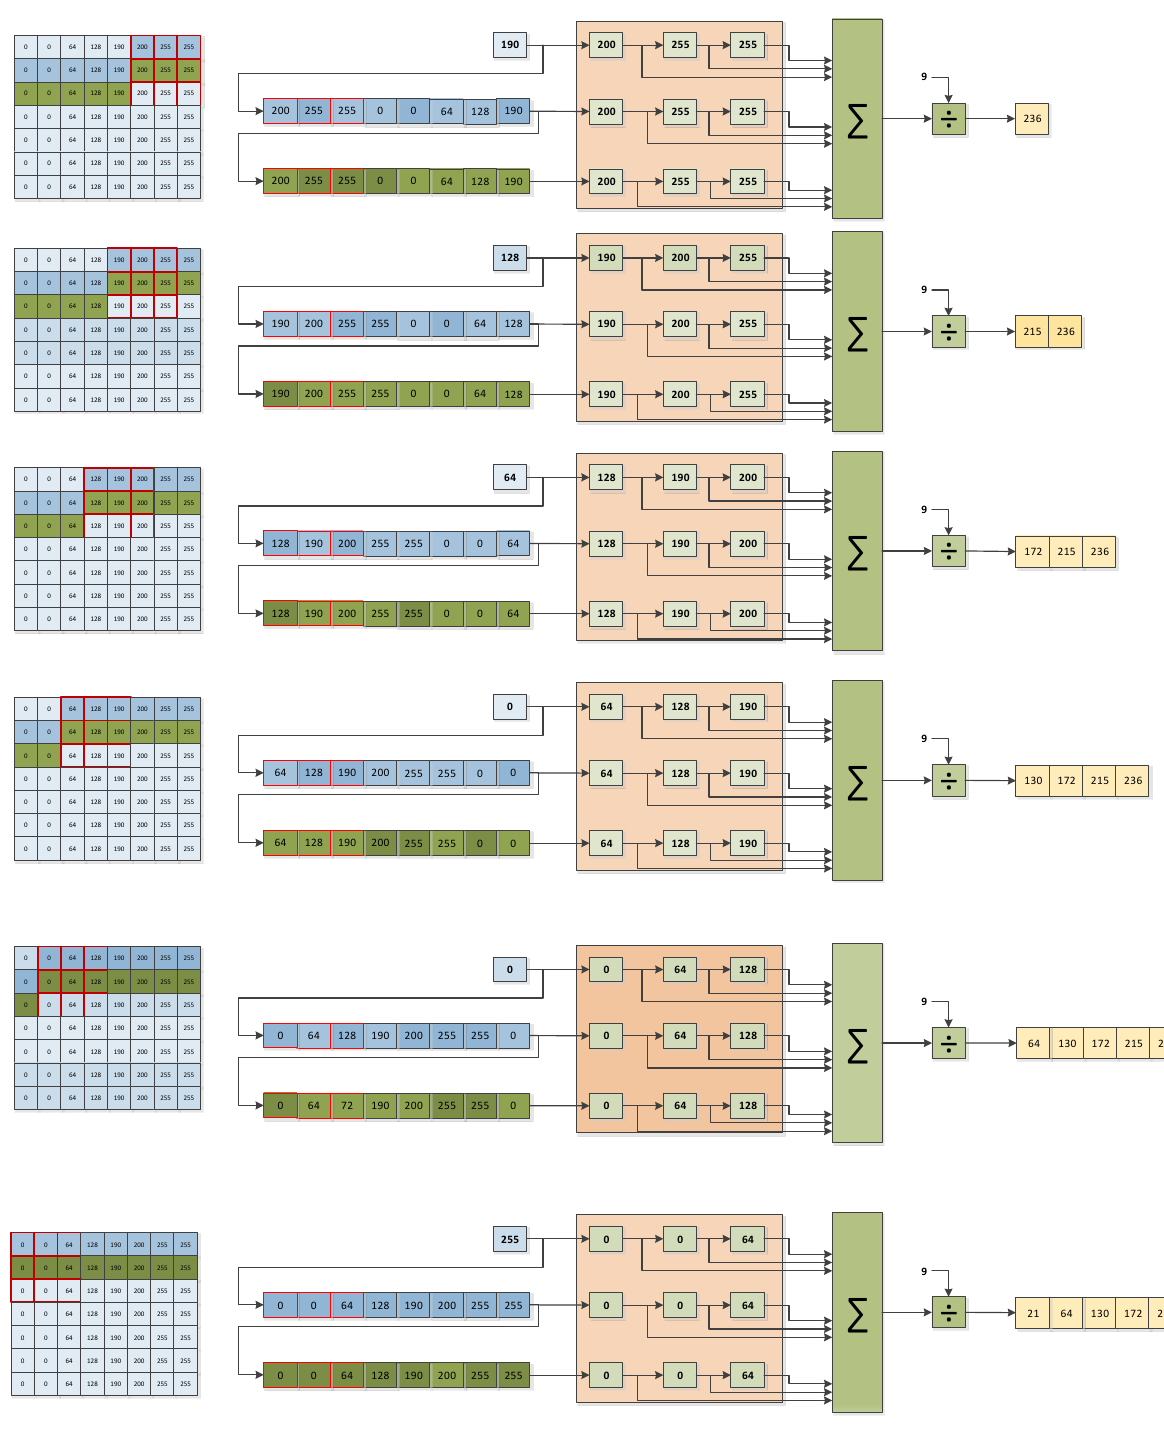
Figure 5. Image average filter on an FPGA. Different successive iterations of the image processing